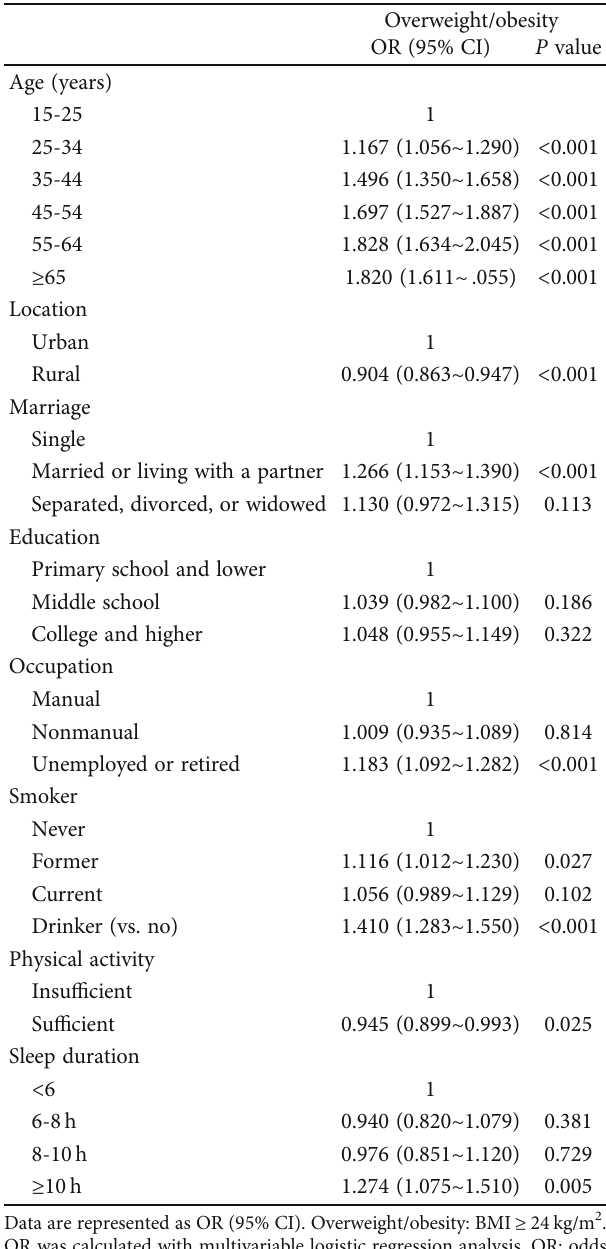
Table 3: Factors associated with overweight/obesity by multivariate logistic regression analysis in Baoji